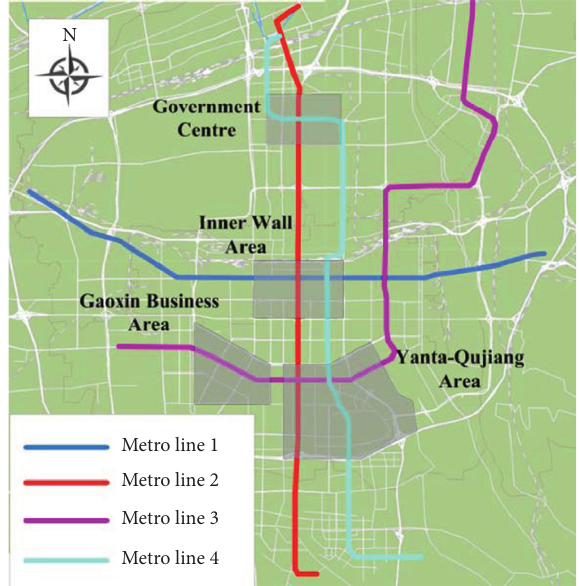
Figure 1: Deployment of the urban rail transit system in